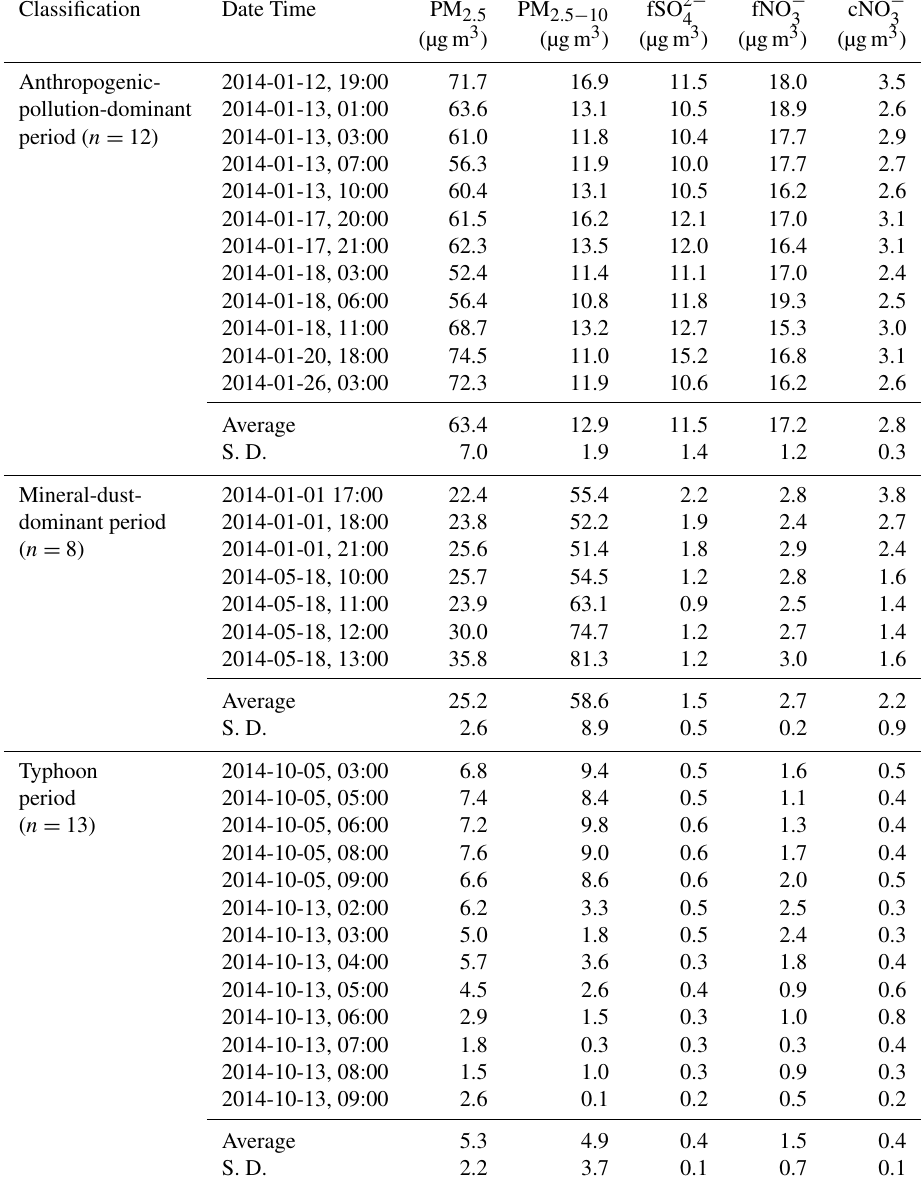
, fNO − , and cNO − for three distinct aerosol-dominant 4 3 3